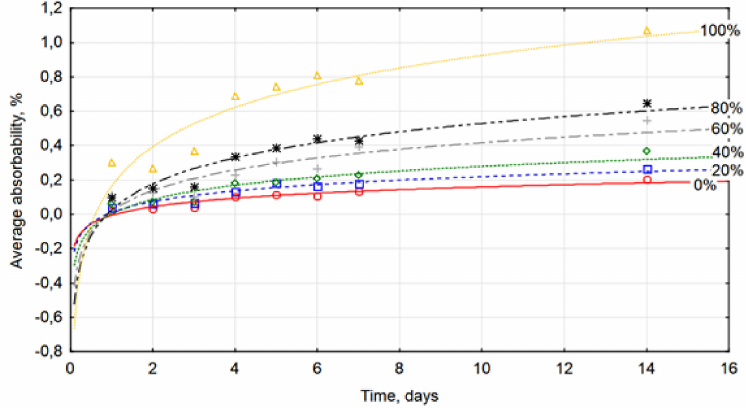
Figure 6. Graphs of functions describing the dependence of water absorption on the duration of immersion in